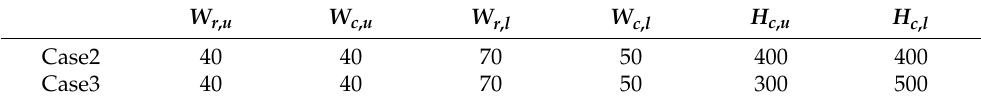
Table 2. Structural parameters of the proposed double-layer microchannel sink (unit: µ m).